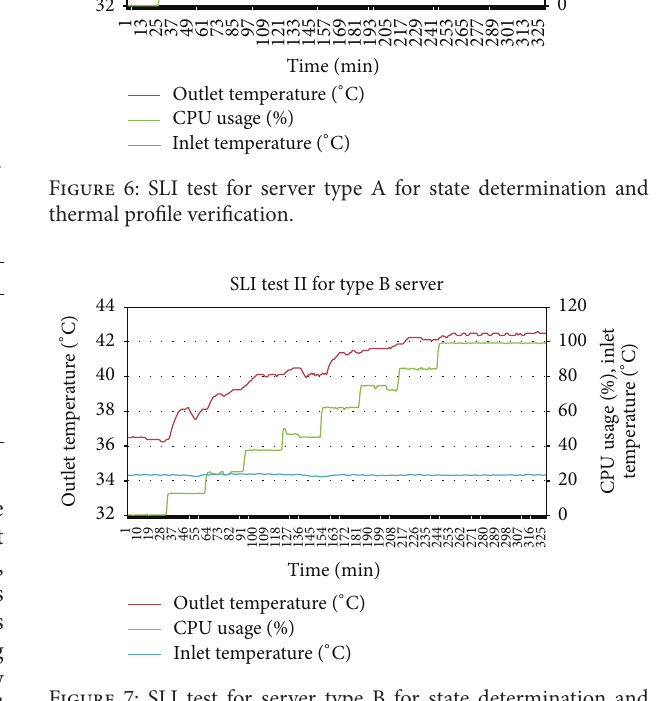
Figure 7: SLI test for server type B for state determination and thermal profile